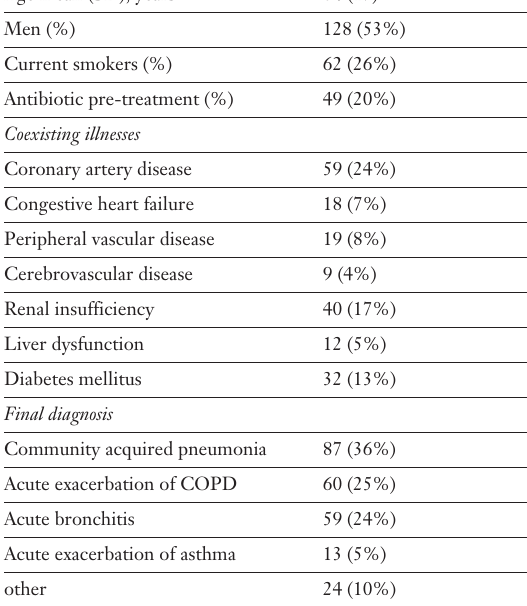
Table 1 Baseline characteris- tics of 243 patients with lower respi- ratory tract